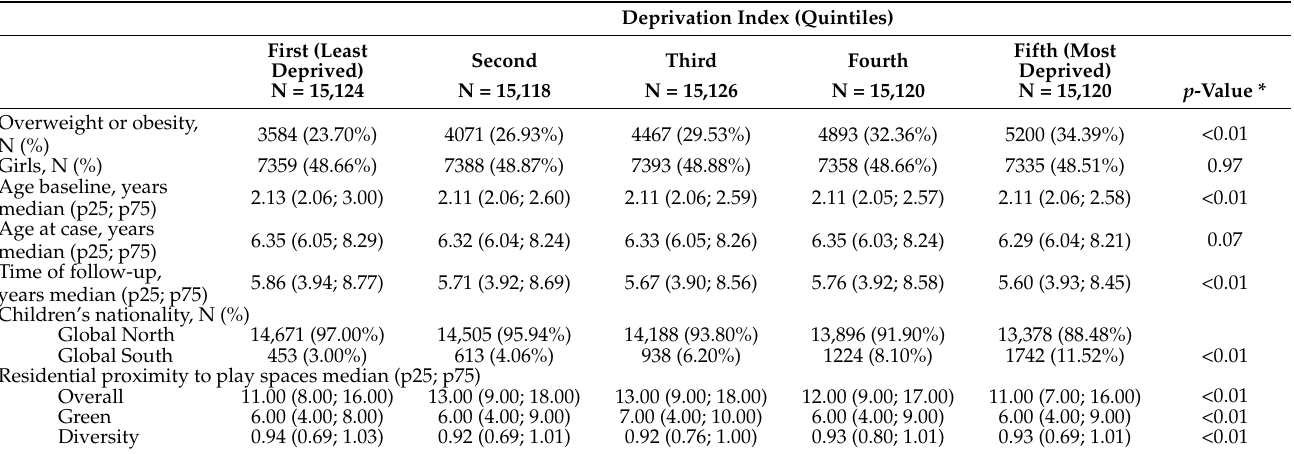
Table 2. Descriptive characteristics of the study population by area SES (quintiles of deprivation) (N =